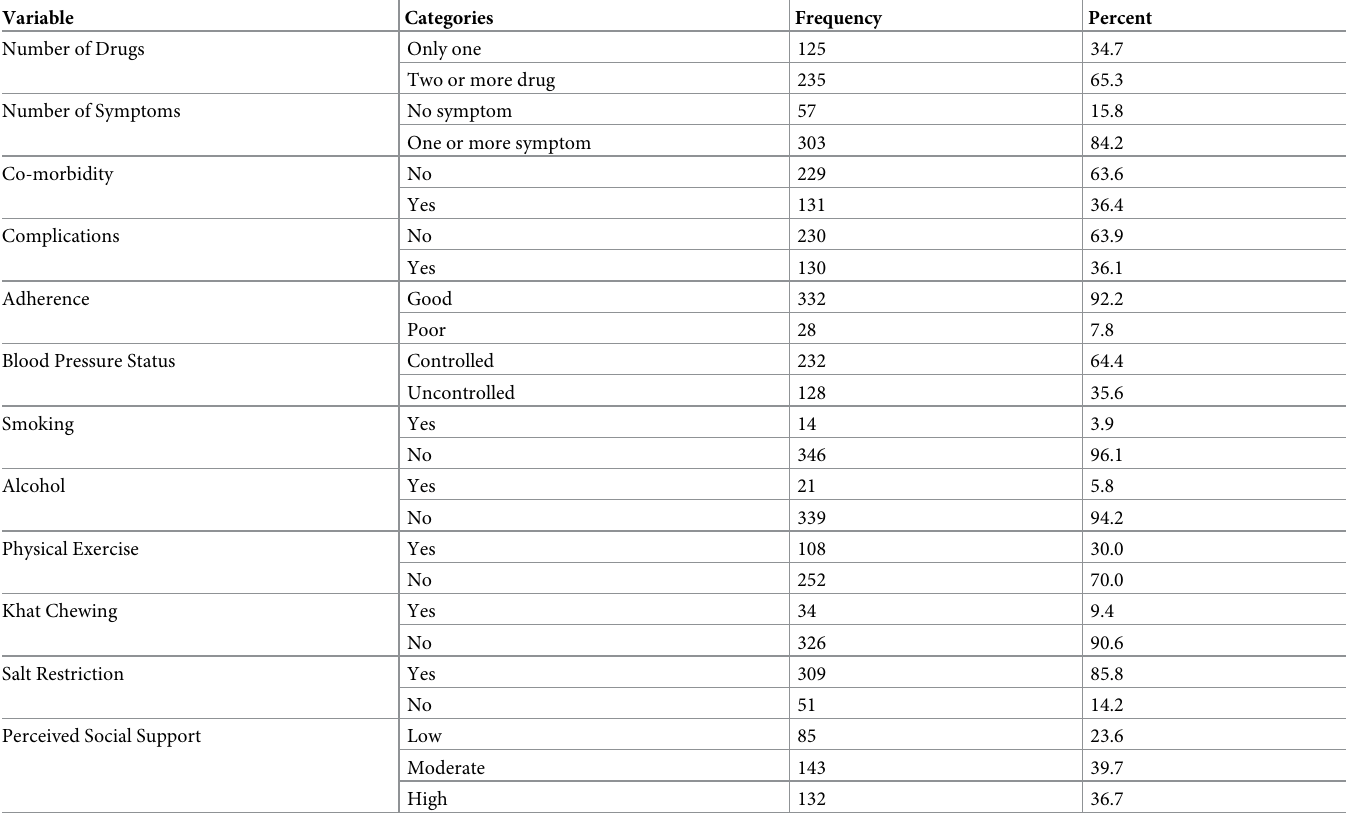
Table 2. Clinical and life style factors of hypertension patients on treatment attending public health facilities in Dessie City Administration, Dessie, Northeast Ethi- opia 2021.